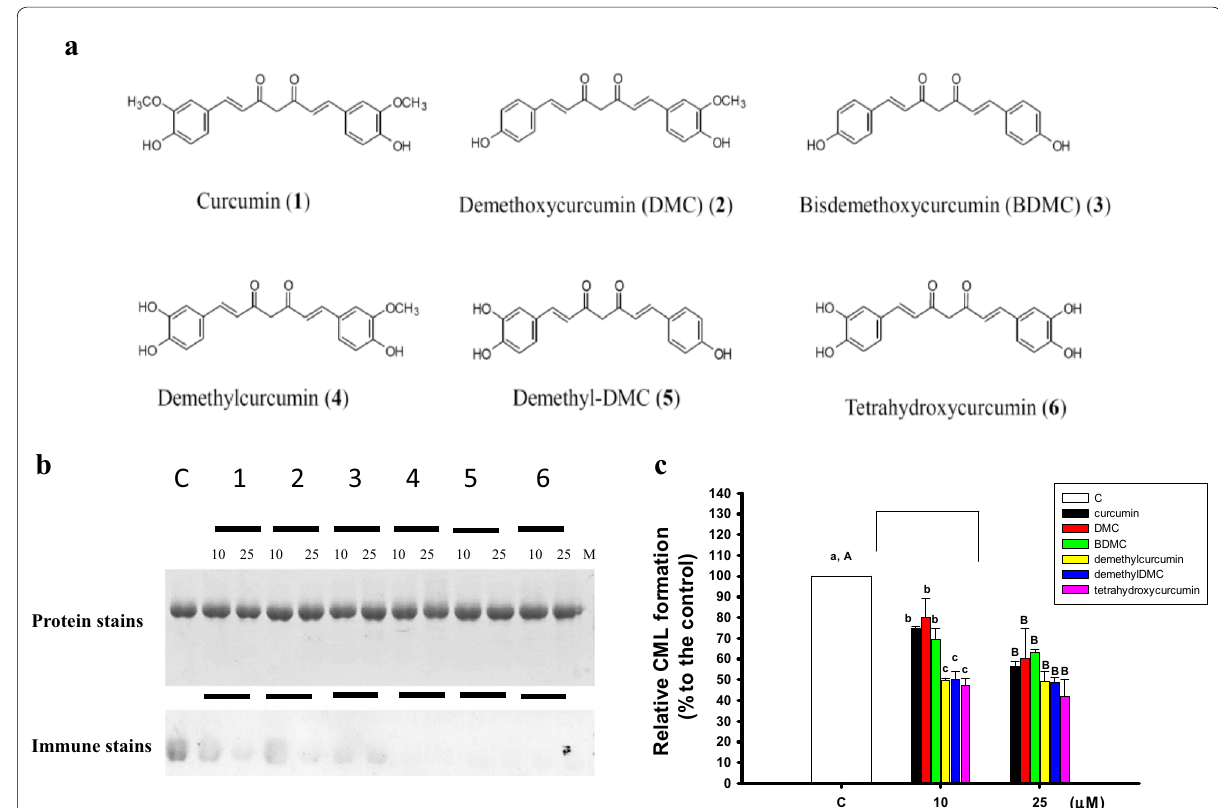
Fig. 1 The anti‑glycation activities of six curcuminoids (10 and 25 μM) in BSA/galactose models. a Six curcuminoids, including curcumin ( 1 ), demethoxycurcumin (DMC, 2 ), bisdemethoxycurcumin (BDMC, 3 ), demethylcurcumin ( 4 ), demethyl‑DMC ( 5 ), and tetrahydroxycurcumin ( 6 ). b The protein stain on the 10% SDS‑PAGE gels and the immune stain of N ε ‑(carboxymethyl)lysine formations on the PVDF membranes. c The quantification of the relative N ε ‑(carboxymethyl)lysine formations. Values were presented as mean followed by a post hoc Tukey’s test for multiple comparisons. The P < 0.05 was considered statistically significant and marked with different letters among the control and treatments under the same